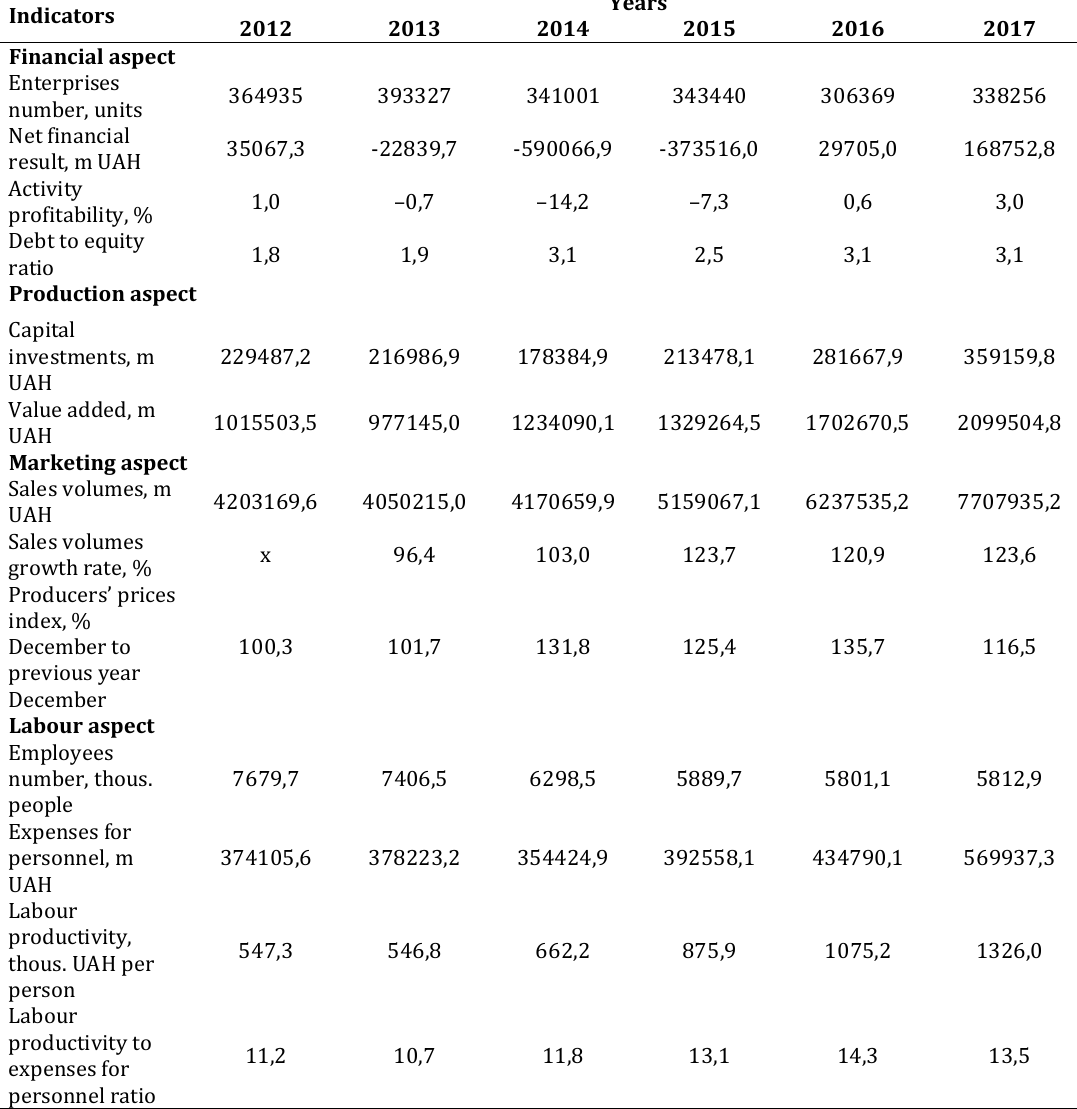
Table 1: The indicators of Ukrainian enterprises activity in 2012-2017*